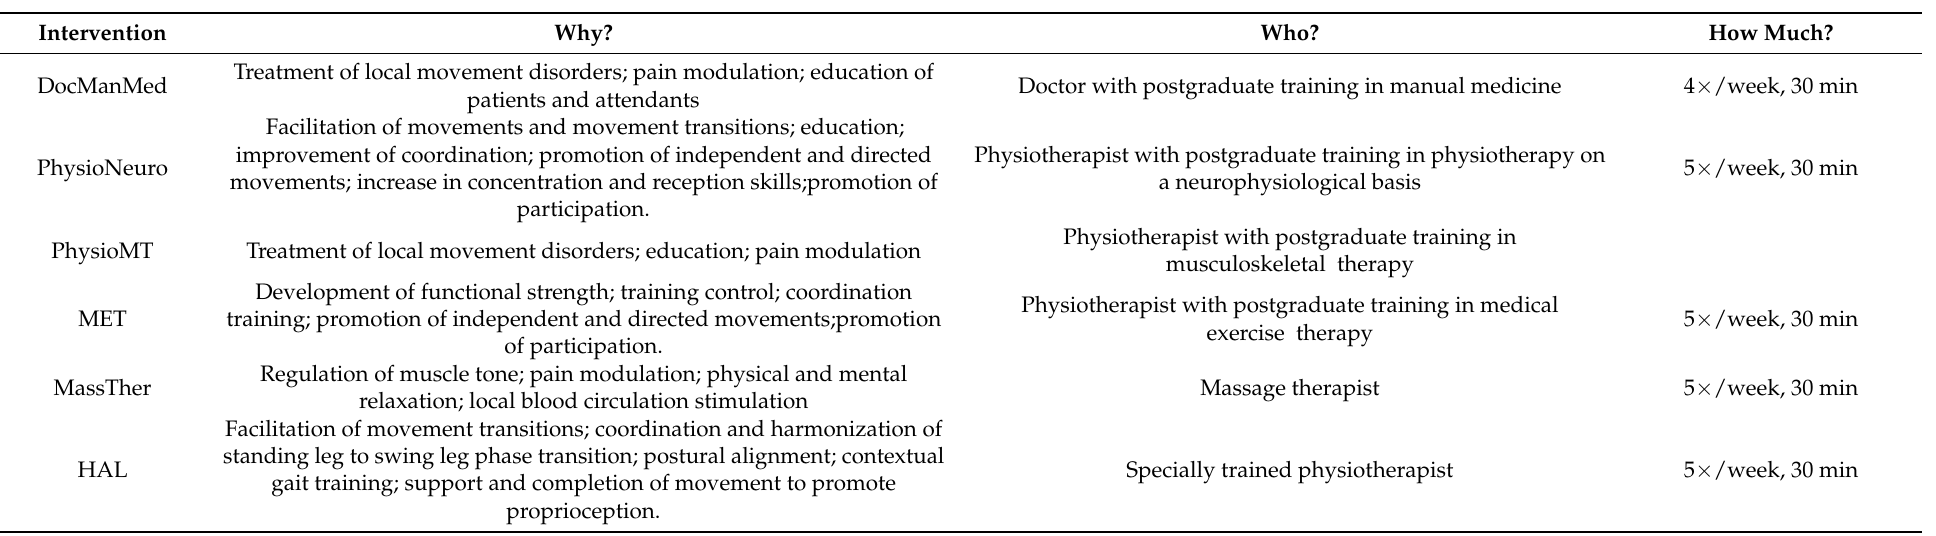
Table A1. List of interventions carried out in the inpatient therapy concept according to the Template for Intervention Description and Replication (TIDieR) Checklist and